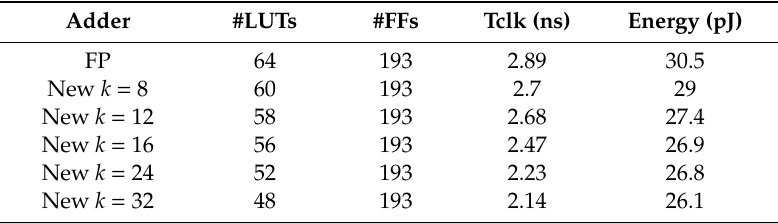
Table 3. Post-layout characterization results of 64-bit adders.